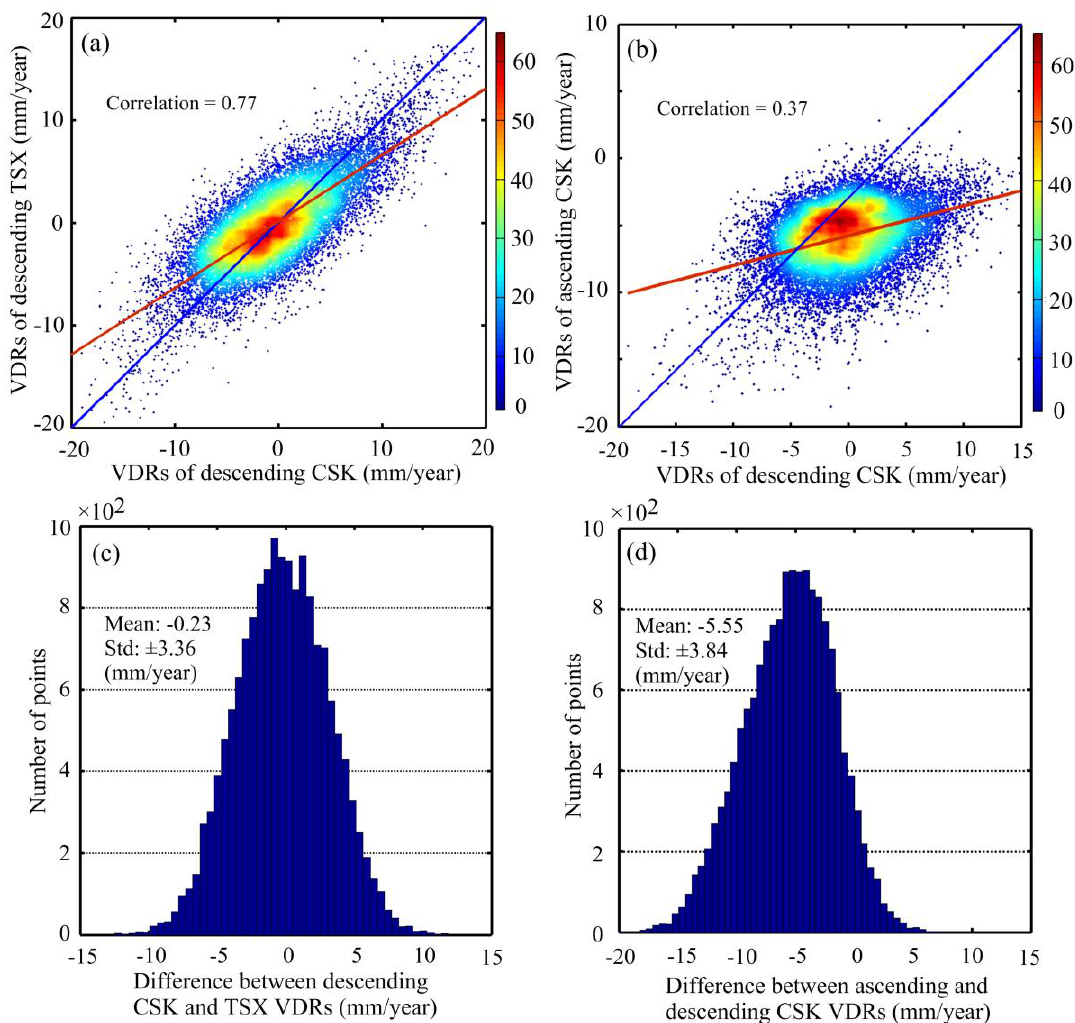
Figure 5. The comparison between the VDRs derived from the different cases of SAR images ( a – d ). (a,c) show the scatterplot and the difference histogram, respectively, of the descending CSK against descending TSX VDRs, while (b,d) show the comparisons of the ascending against descending CSK VDRs. The red lines and the colorbar in (a,b) are the best-fit lines and the frequency number of